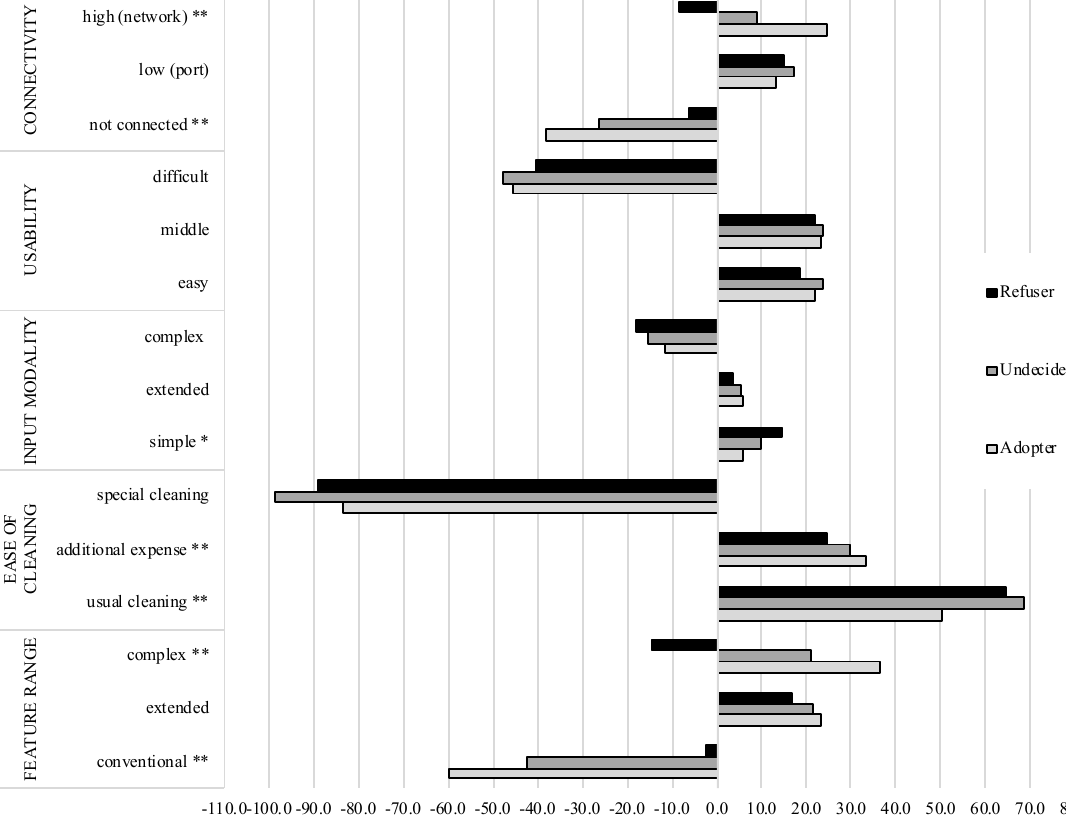
Figure 5. Part-worth utilities of all attribute levels for the smart jacket referring to three user groups (* = p < 0.05; ** = p <